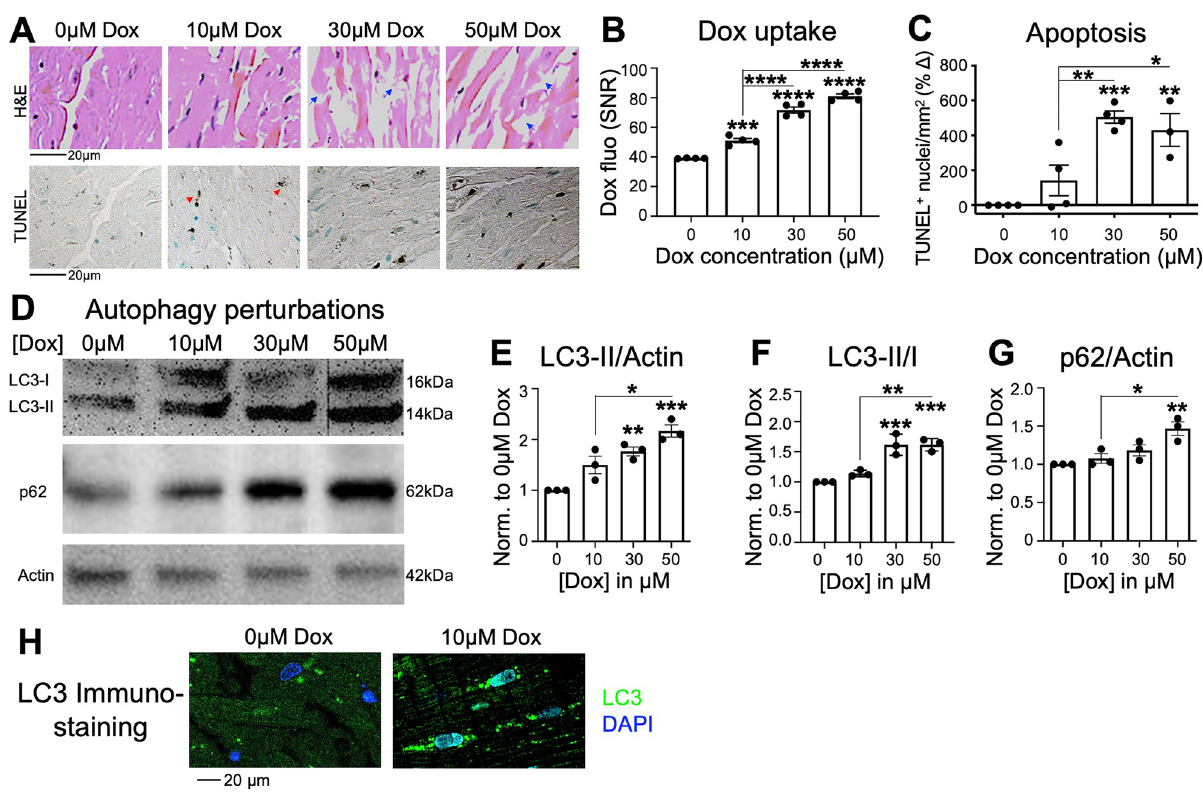
Fig 3. Doxorubicin induces cardiac tissue damage, apoptotic cell death, and impairs autophagy. Canine cardiac slices were exposed to increasing concentrations of doxorubicin (Dox, 10–50 μ M) for 24 hours. A. Representative H&E and TUNEL stained sections exposed to 0–50 μ M of doxorubicin. 0 μ M: Bellingham grade 0; 10 μ M: Bellingham grade 2; 30 and 50 μ M: Bellingham grade 3. Blue arrows: disorganized myocyte fibers. Red arrows: TUNEL+ nuclei. B. Quantification of doxorubicin retention in cardiac slices by direct fluorescence tissue imaging. SNR = signal-to-noise ratio. N = 4. C. Quantification of TUNEL+ nuclei in cardiac slices exposed to 0, 10, 30, or 50 μ M of doxorubicin for 24 hours (n = 4). D-G. Representative western blots and quantification of autophagy proteins (LC3-II, p62) in slices treated with increasing concentrations of doxorubicin for 24 hours. N = 3. H. Immunostaining of LC3 demonstrated robustly increased LC3 accumulation (green = LC3, blue = DAPI) in cardiomyocytes of slices exposed to doxorubicin. � p < 0.05, �� p < 0.01, ��� p < 0.001, ���� p < 0.0001 compared to untreated controls unless otherwise noted, ANOVA with Tukey post-test.